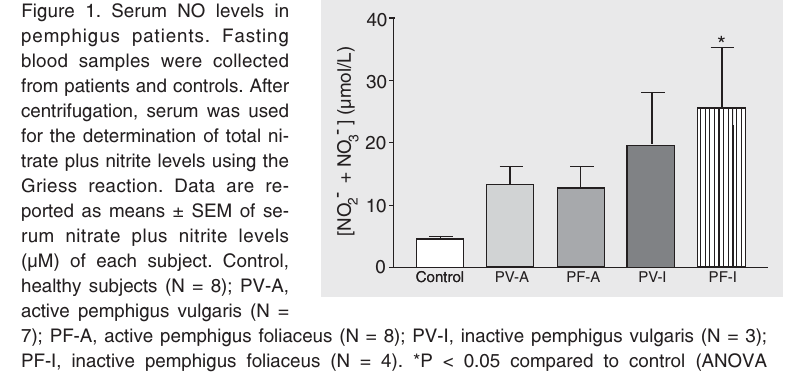
expression (data not shown). Figure 1. Serum NO levels in pemphigus patients. Fasting blood samples were collected from patients and controls. After centrifugation, serum was used for the determination of total ni- trate plus nitrite levels using the Griess reaction. Data are re- ported as means ± SEM of se- rum nitrate plus nitrite levels (µM) of each subject. Control, healthy subjects (N = 8); PV-A, active pemphigus vulgaris (N = 7); PF-A, active pemphigus foliaceus (N = 8); PV-I, inactive pemphigus vulgaris (N = 3); PF-I, inactive pemphigus foliaceus (N = 4). *P < 0.05 compared to control (ANOVA followed by Tukey